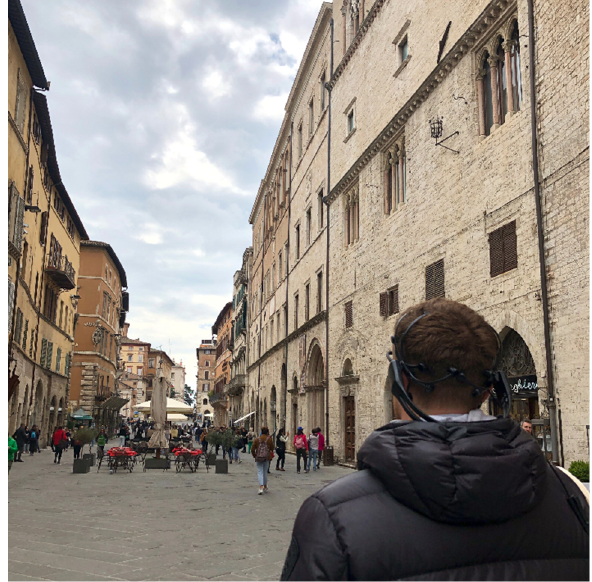
Figure 5 - Data acquisition in